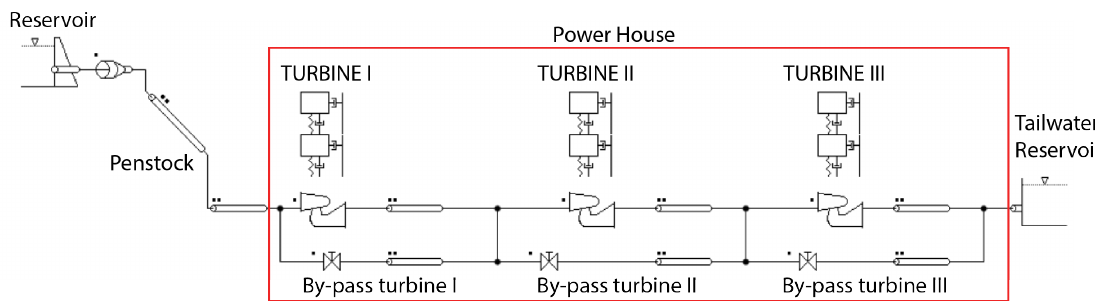
Figure 9. SIMSEN components to simulate the Péronnes-lez-Binche power